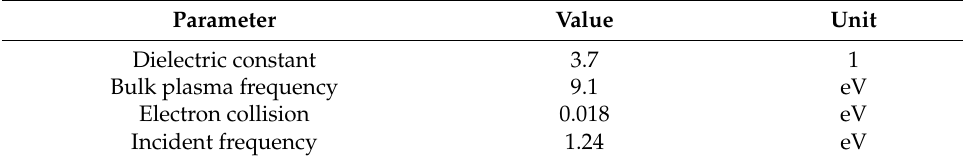
Table 2. Drude parameter for silver. Parameter Value Unit Dielectric constant 3.7 1 Bulk plasma frequency 9.1 eV Electron collision 0.018 eV Incident frequency 1.24